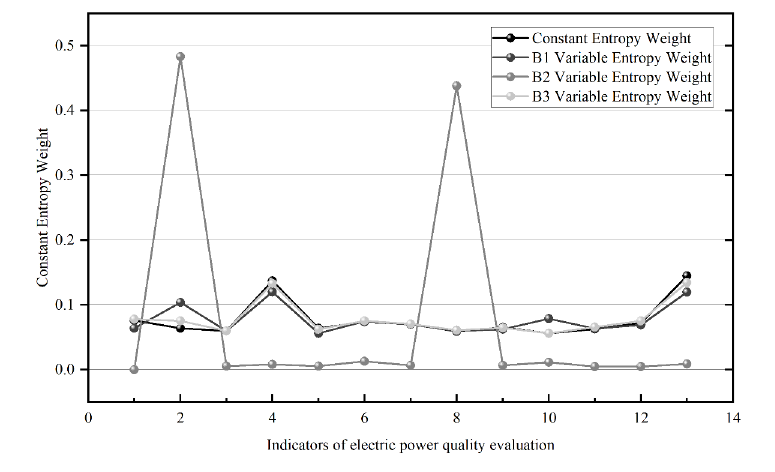
Fig. 2. The objective weights of variable weight